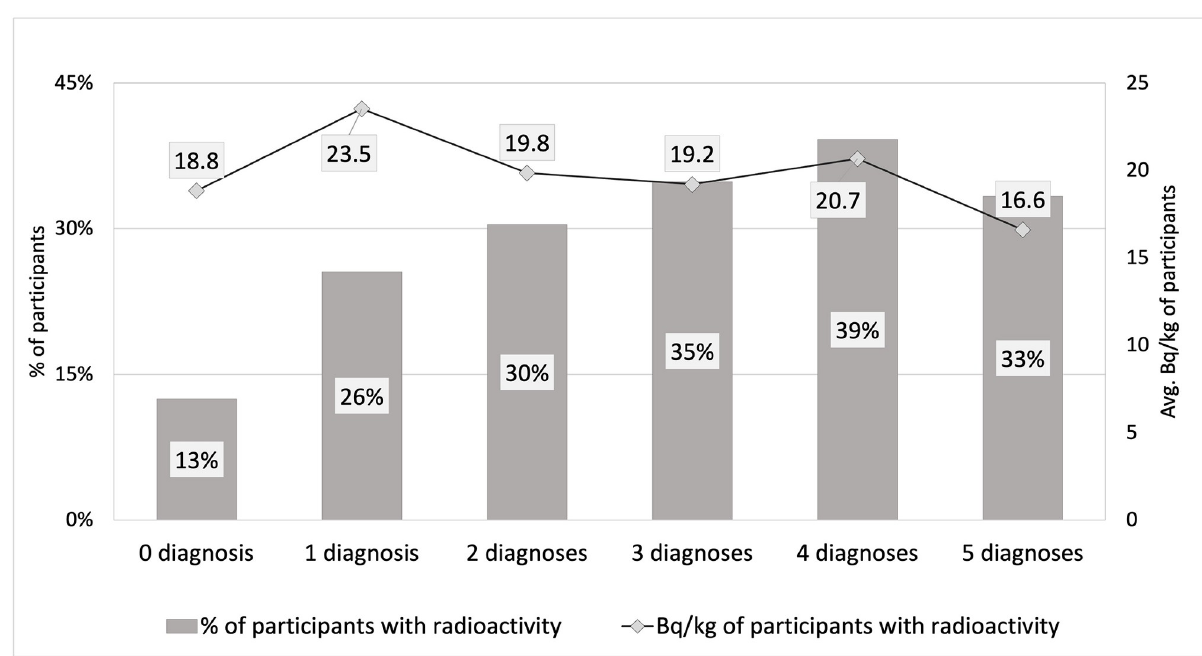
Fig 3. Bq/kg and percentage of participants with detected radiation in each number of upper GI endoscopic diagnosis groups. Avg . Despite the percentage of detected people seemingly increasing with the increase in the number of upper GI endoscopic diagnosis, the black line shows the average Bq/kg and implies no association with the